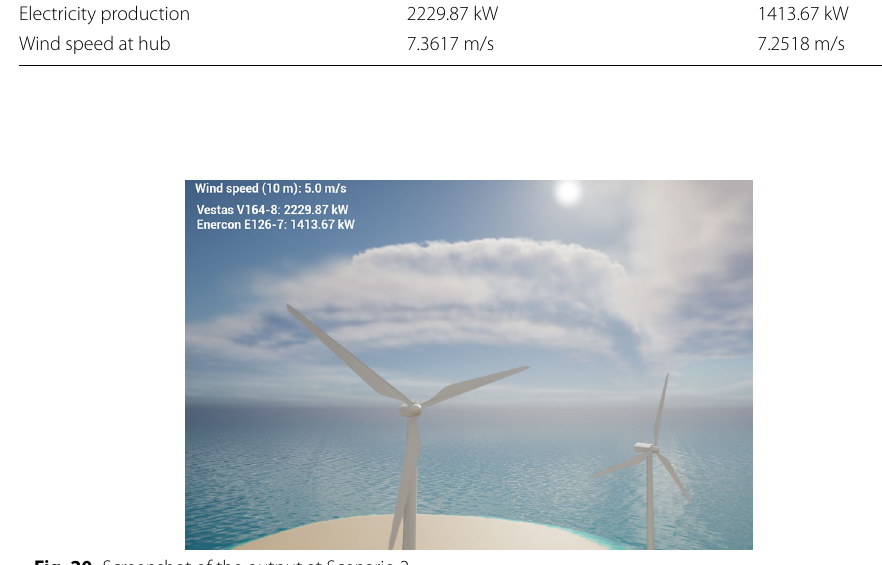
Fig. 20 Screenshot of the output at Scenario